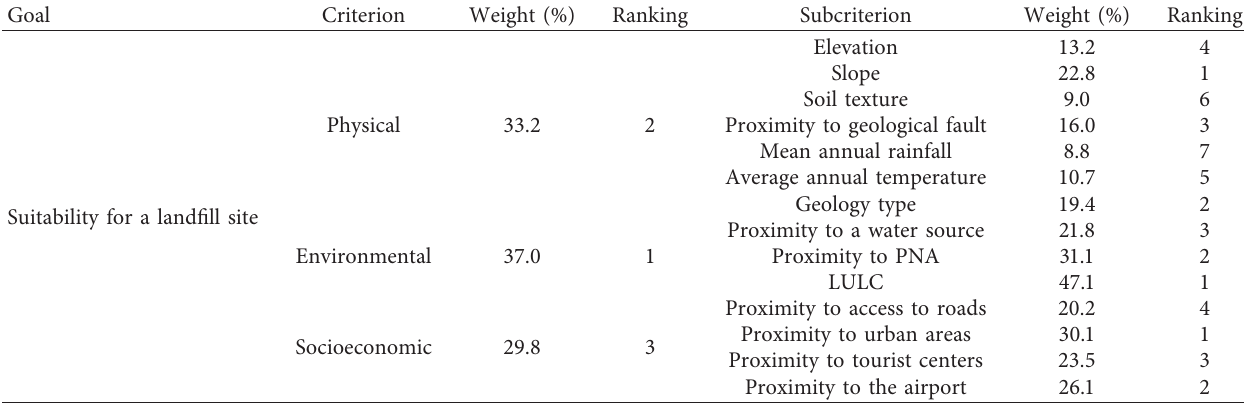
Table 5: Weights of importance for the criteria and subcriteria for modeling the suitability of the territory of Chachapoyas and Huancas, NW Peru for a